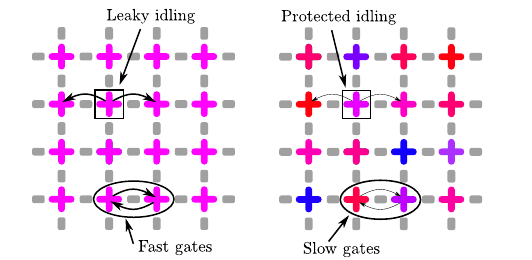
Fig.1|Many-qubitprotection-operationdilemma. Withnofrequencydisorderin qubits, one can apply fast two-qubit gates but the idle qubits rapidly leak quantum information. On the other hand, in suf fi ciently disordered systems, the quantum states are quasi-localized, rendering the idle qubits well protected. A downside is thatthetwo-qubitgatesarelessef fi cient.Crossesvisualizesuperconductingqubits and their colors indicates transition frequencies. Gray bars denote qubit-qubit interactions.